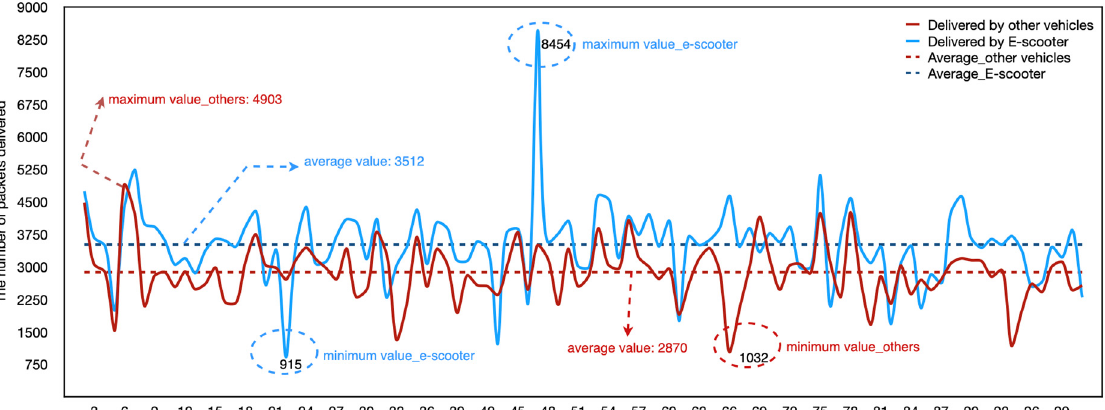
Figure 8. The number of packages distributed with e-scooters and other vehicle delivery person- nel.